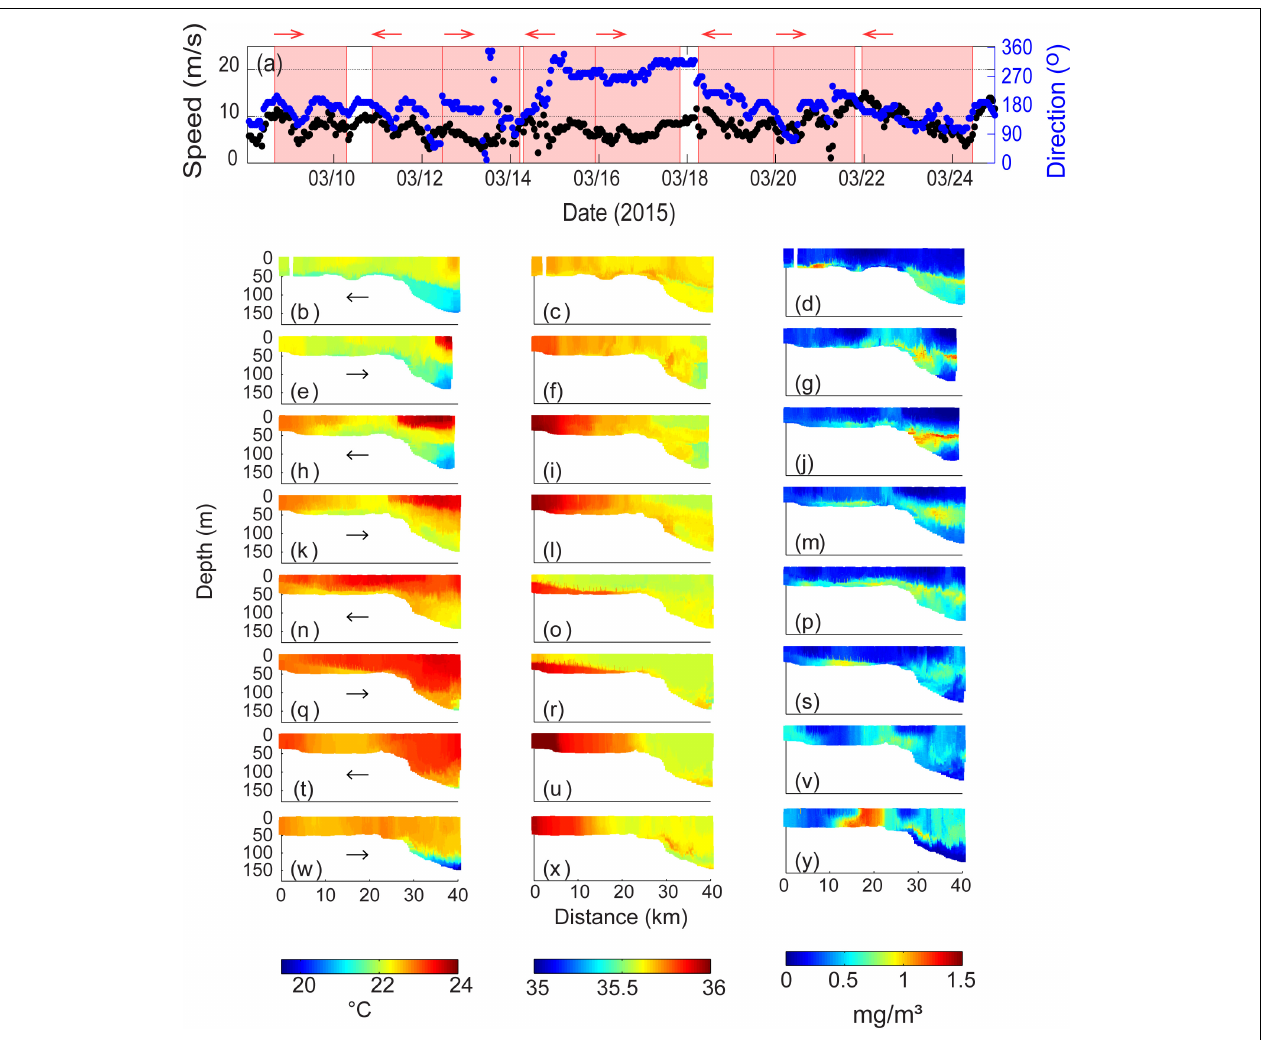
FIGURE 13 | (a) Wind velocity and direction at Rottnest Island during 8–24 March 2015. The shaded areas represent the period of ocean glider transect; Ocean glider vertical cross-sections of (b) temperature ( ◦ C); (c) salinity; and (d) chlorophyll (mg m − 3 ) across the Rottnest continental shelf during 8–10 March 2015; (e–g) water properties during 10–12 March 2015; (h–j) water properties during 12–14 March 2015; (k–m) water properties during 14–15 March 2015; (n–p) water properties during 15–18 March 2015; (p–s) water properties during 18–19 March 2015; (t–v) water properties during 19–21 March 2015; and (w–y)